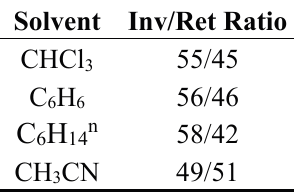
Table 7. The effect of solvents on steric course of the acid catalyzed isopropanolysis of sulfinamide (+)-( S )- 1c